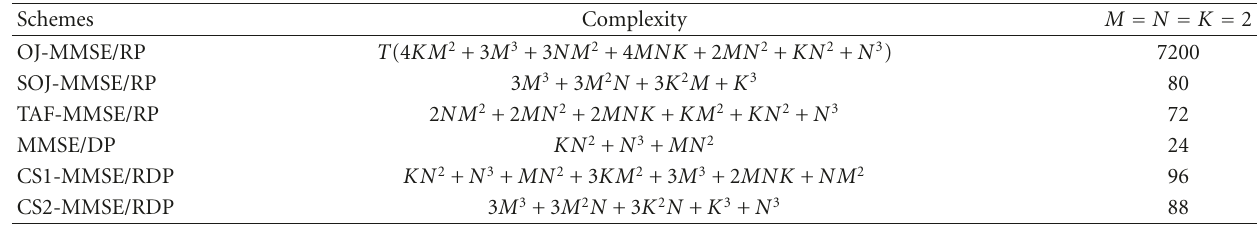
Table 1: Computational complexity of the proposed schemes in downlink systems.